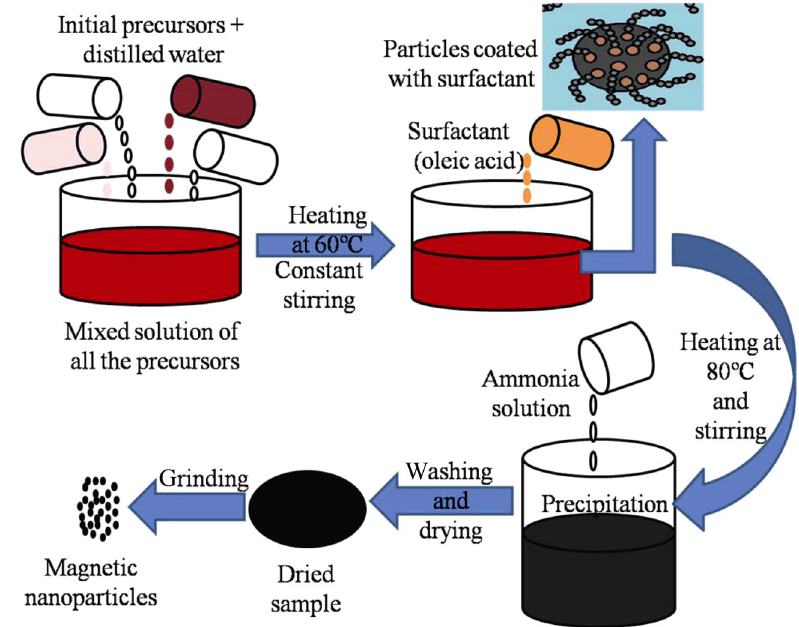
Fig. 1 Schematic diagram of synthesis of developed ferrite nanoparticles.